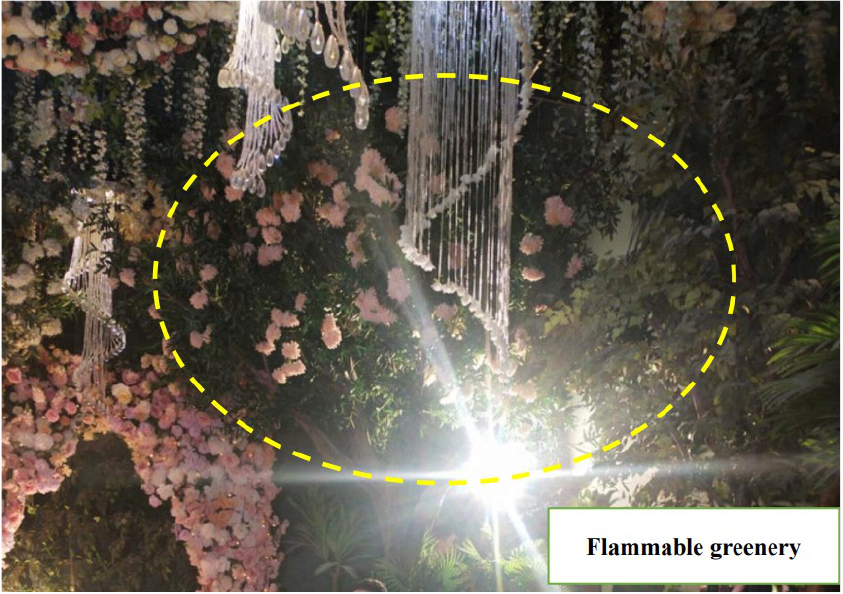
Figure 5. Electrical fires: combustible decorations in the wedding dress shop (picture source: [20]).